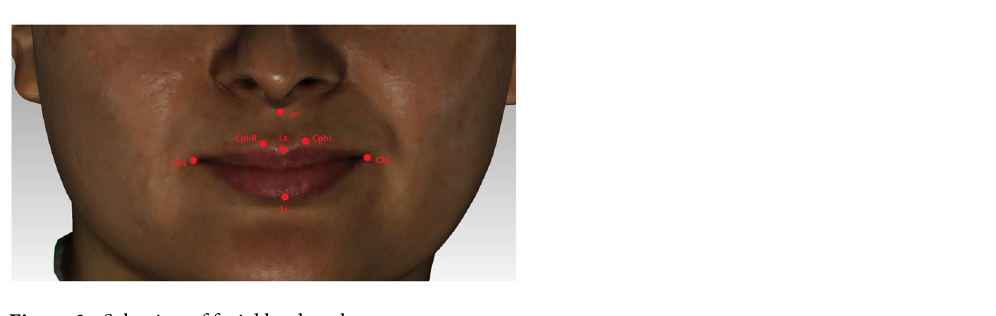
Figure 2. Selection of facial